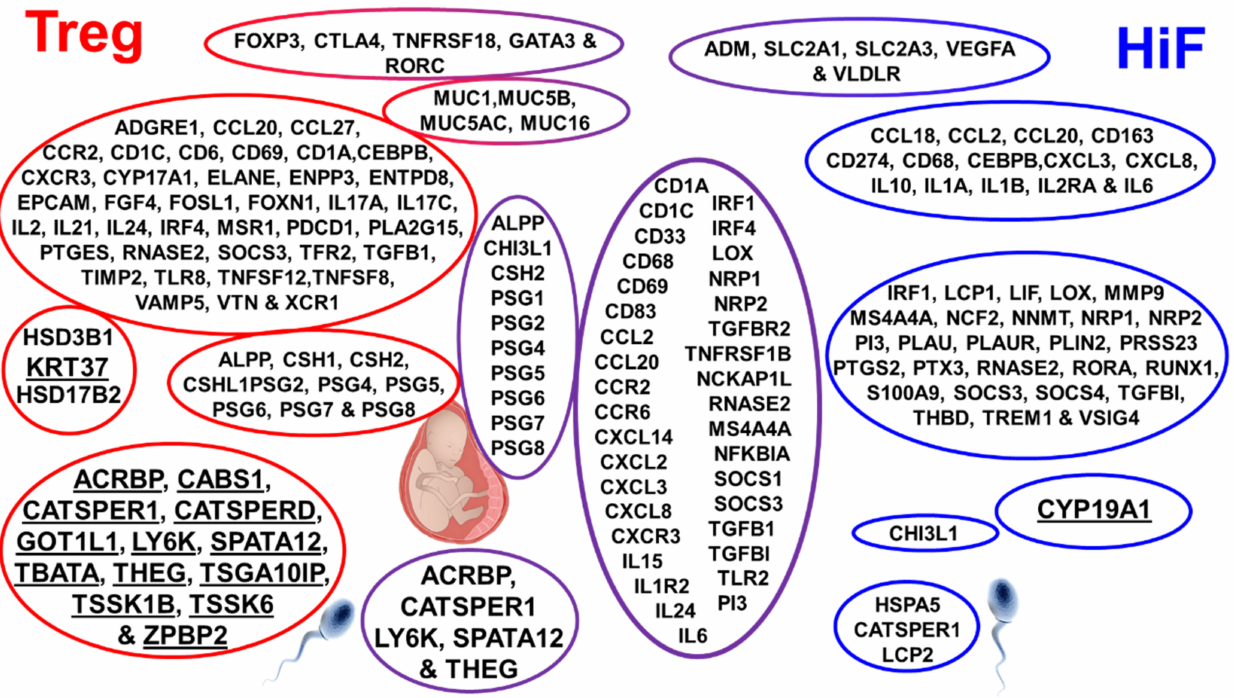
Figure 2. Genes correlated with Treg and HiF clusters: the breakdown of gene expression by high Treg expression subtype (left), high HiF expression subtype (right), and high Treg and HiF expression (middle). Genes clustered and highlighted are sperm/testicular proteins, including ACRBP and gestational genes such as PSGs. The androgen-responsive gene KRT37 is associated with Tregs, as are many reproduction-associated genes, including sperm-specific, placental-associated and mucins genes. In contrast, aromatase ( CYP19A1 ), which converts testosterone to estrogen, is associated with hypoxia. Noteworthy too is the HiF association with immunosuppressive M2 macrophage markers, including CD68 , CD69 , CD163 , MS4A4A , and MDSC inducer MUC1 . We also observe M2 macrophage cytokines CCL2 and CCL13 and IL10 which can give rise to this polarization in hypoxic